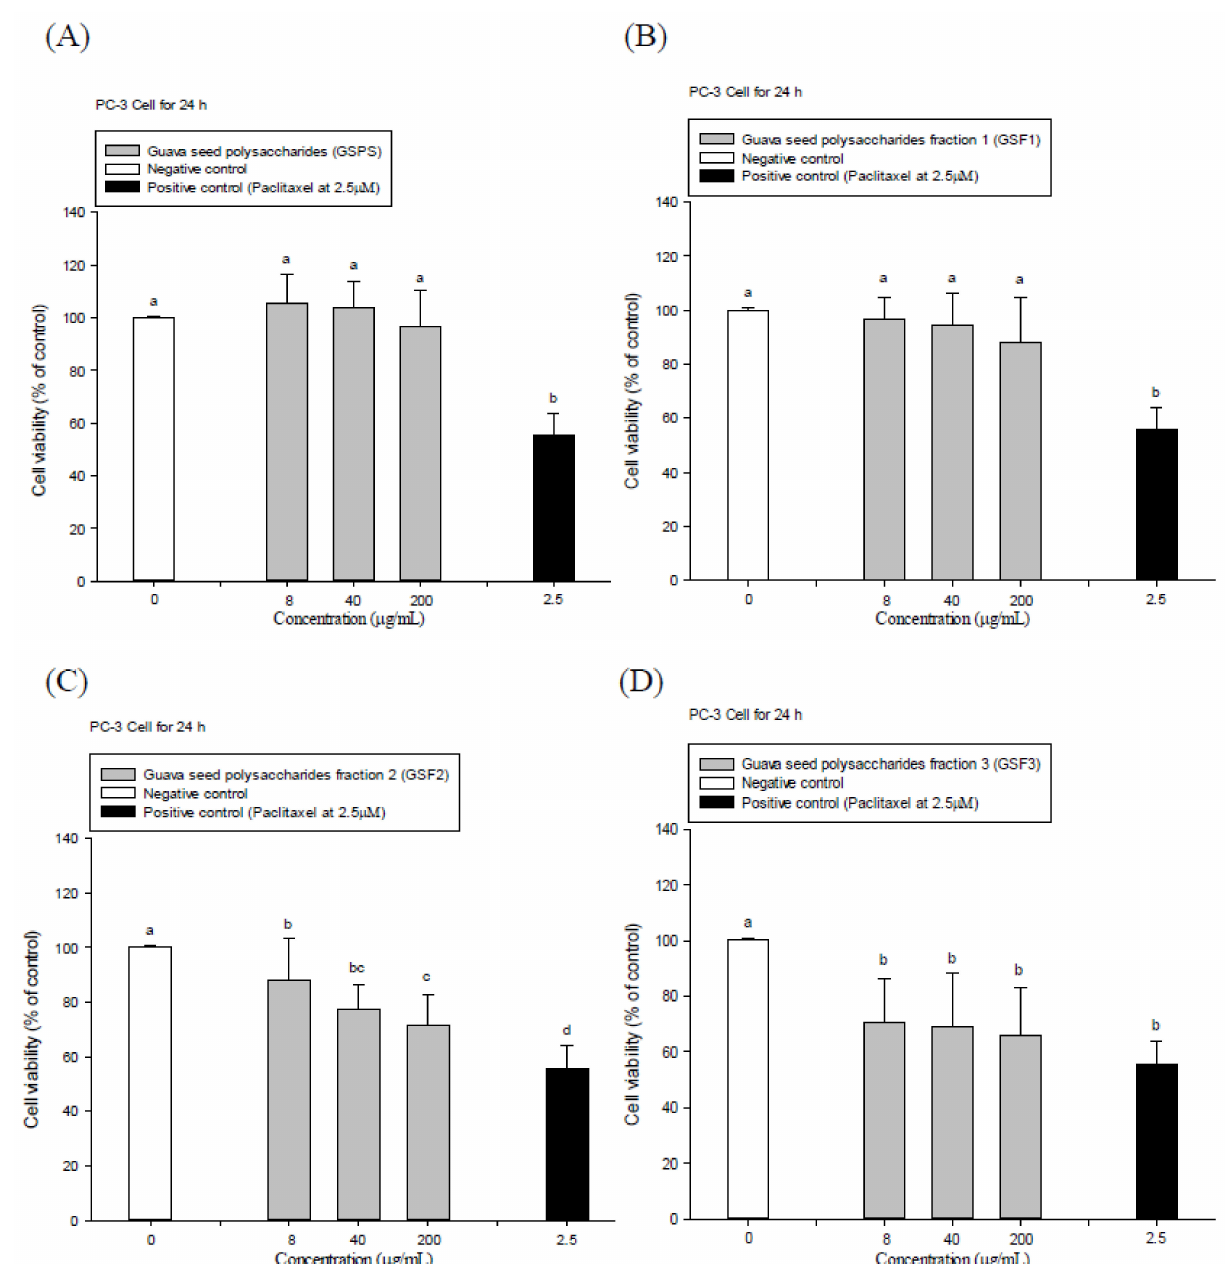
Figure 1. Effects of direct treatments with guava seed polysaccharides (GSPS) ( A ), GSF1 ( B ), GSF2 ( C ), and GSF3 ( D ) for 24 h on PC-3 cell growth. Values are means ± SD (n = 6 biological determinations). Bars in the plot not sharing a common letter are significantly different ( p < 0.05) from each other analyzed by one-way ANOVA, followed by Duncan’s multiple range test. Each cell population (2 × 10 5 cells/mL) was respectively treated with the polysaccharides at the indicated concentrations of 8, 40, and 200 µ g/mL, as well as paclitaxel (a positive control) at 2.5 µ M. The cell viability was determined using MTT